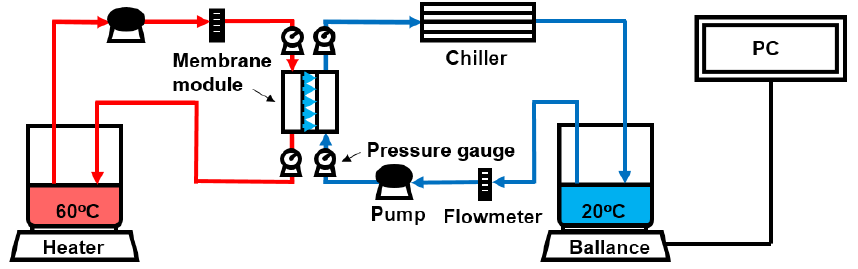
Figure 2. Schematic diagram of an equipment for DCMD experiments.